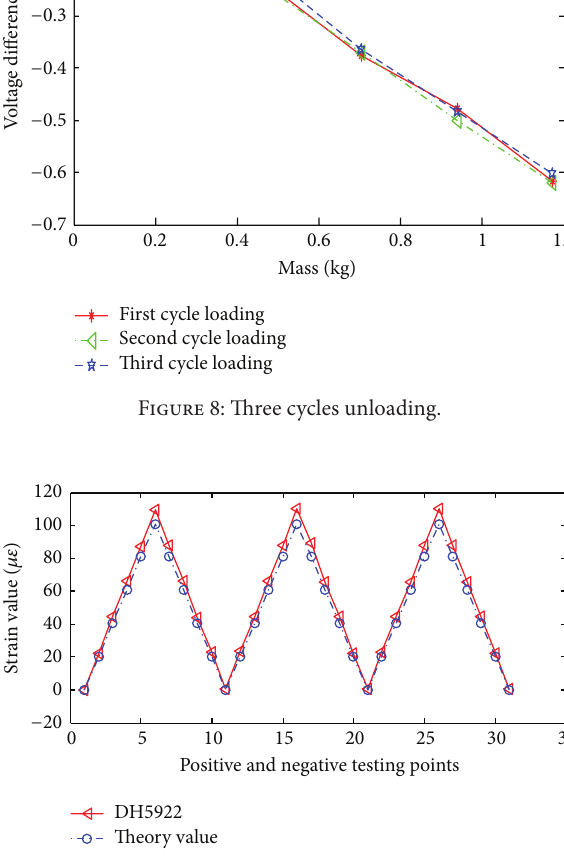
Figure 9: Strain data measured by DH5922 versus theoretic value.